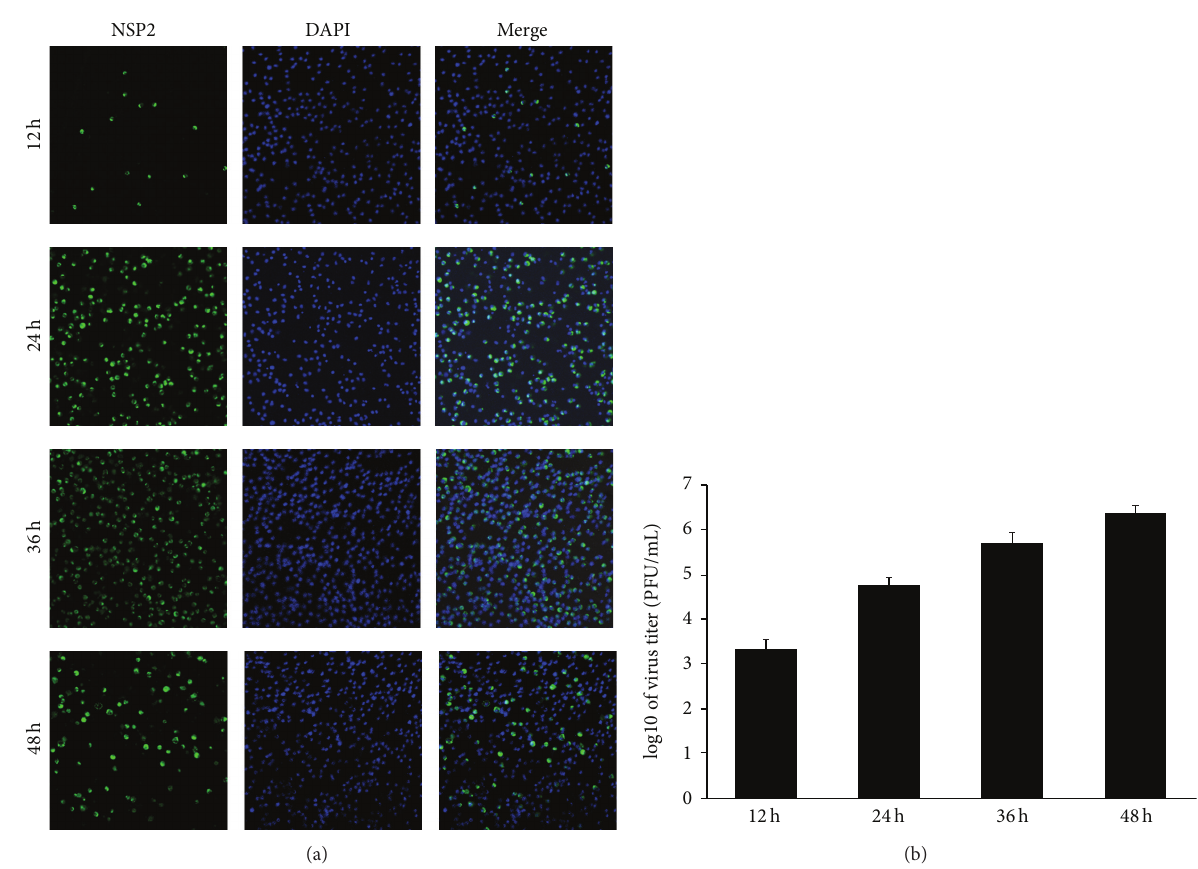
Figure 1: Infection kinetics of the highly pathogenic PRRSV strain WUH3 in PAMs. (a) PAMs were infected with the adapted PRRSV (3rd passages) at an MOI of 0.1. Cells were fixed and permeabilized in cold methanol at different time point (12, 24, 36, and 48h) postinfection. Immunofluorescence assays were performed to analyze the replication of PRRSV by detecting the nonstructural protein Nsp2 (green fluorescence). DAPI (4 󸀠 ,6-diamidino-2-phenylindole) was used to stain the nuclei. (b) PAMs were infected with the adapted PRRSV at a MOI of 0.1. Supernatants were collected at different time point (12, 24, 36, and 48 h) postinfection for plaque assay to determine viral